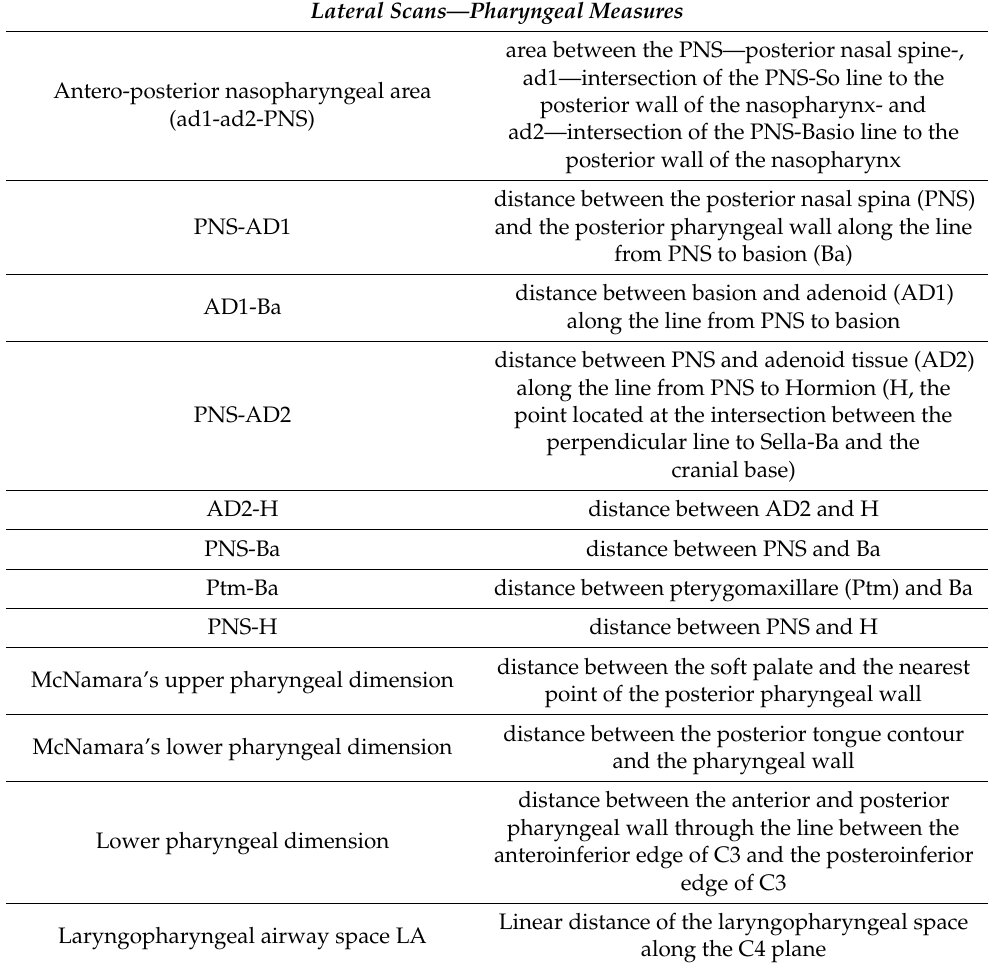
Table 3. Effects of RME on airway dimensions and volume: lateral scans vs. pharyngeal